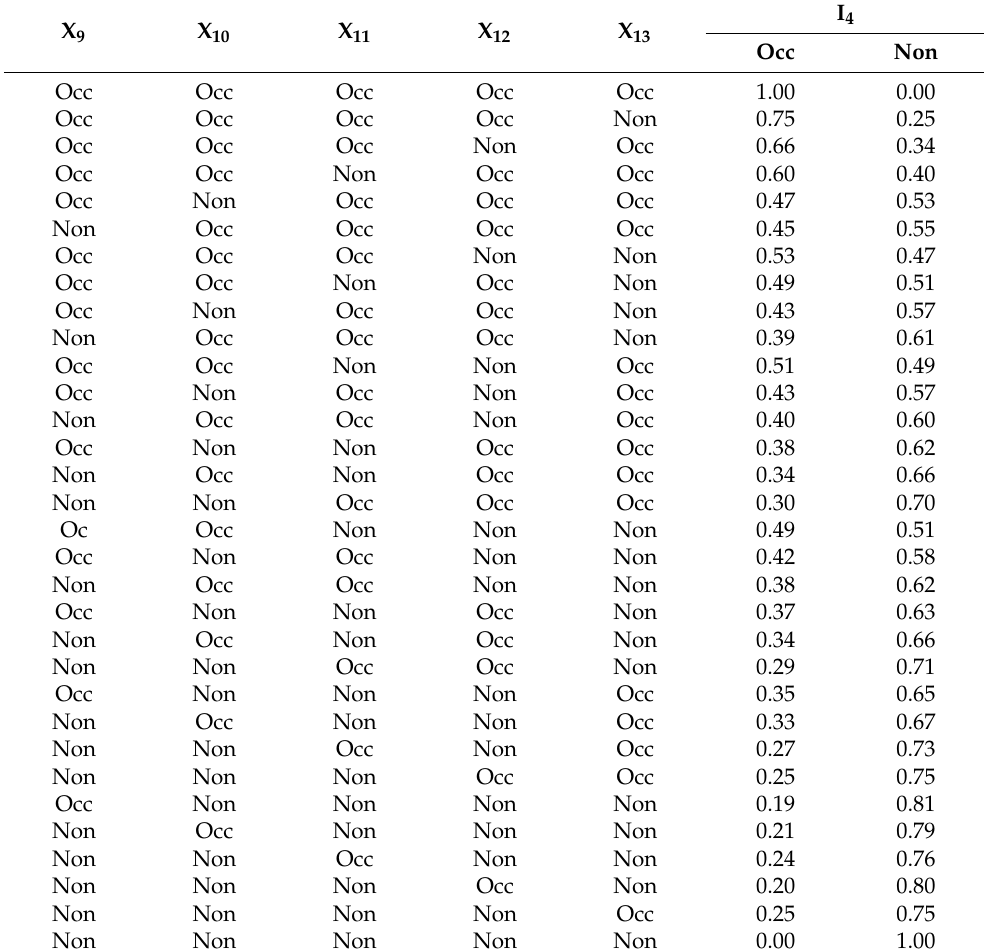
Table A3. The CPT of event I 4 (Too-high temperature; Occ: occurred; Non: non-occurred).